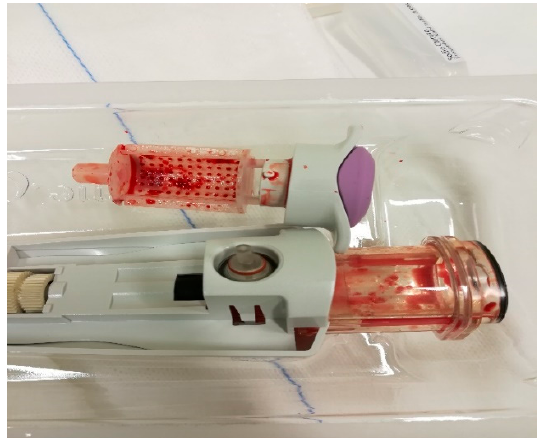
Figure 3. Samples collected automatically in a small easily extractable radio ‐ transparent container using the CB system.